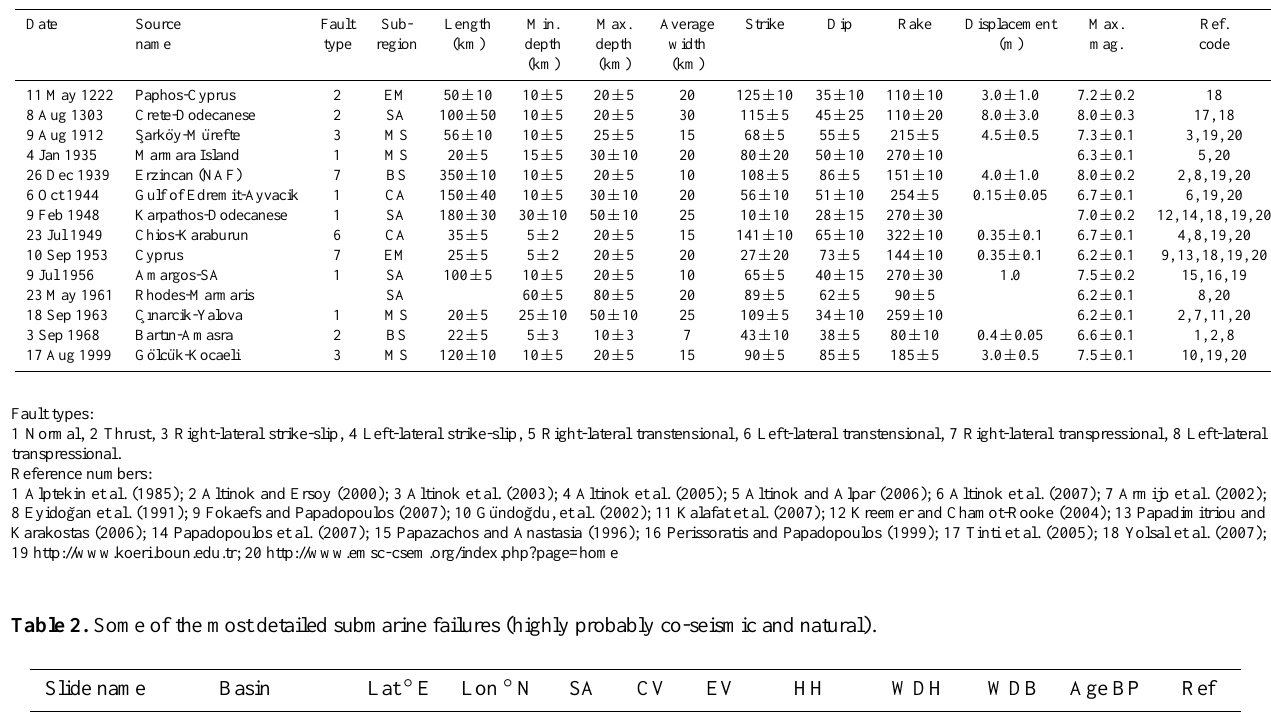
Table 1. Some of the most detailed tsunamigenic event sources.